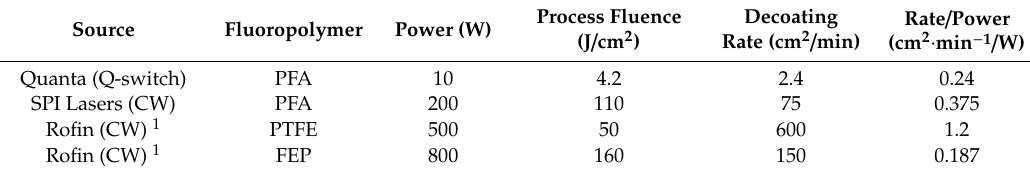
Table 8. Power, process fluence, stripping rate and rate / potency values for PFA, PTFE, and FEP fluoropolymer